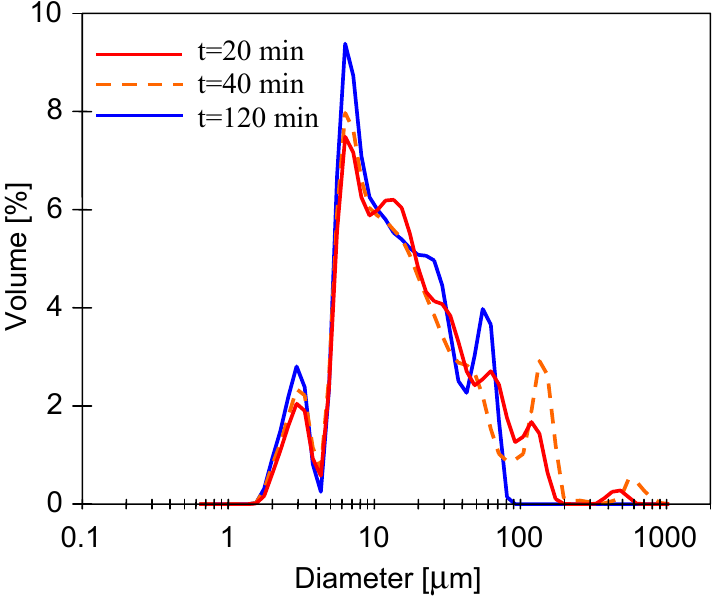
Figure 14. Changes in the droplet size distribution in real oily wastewater #1 during the MF process. Module MF1, TMP = 0.05 MPa, T = 22 °C, V F = 0.5 m/s.